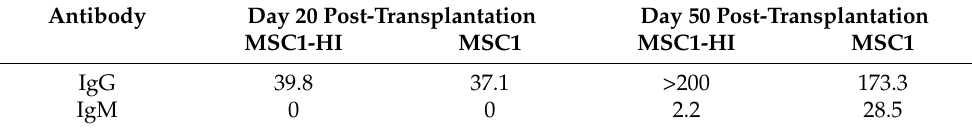
Table 1. Deposition of IgG and IgM on MSC1 and MSC1-HI grafts.